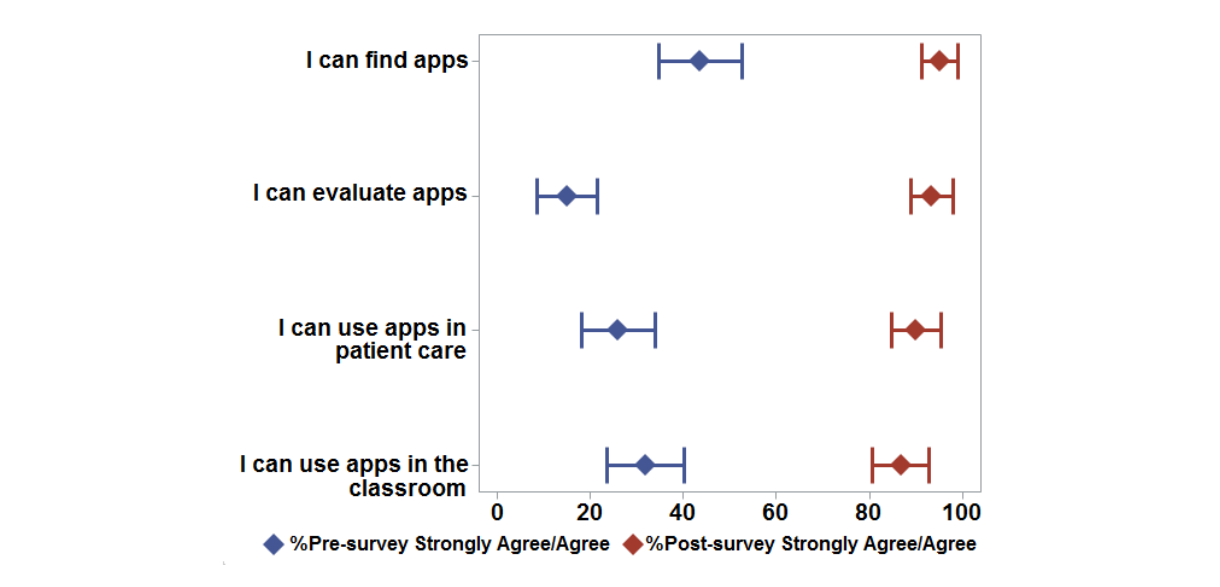
Figure 2. Student assessment of evaluation technique. Proportions (diamonds) and 95% confidence intervals (horizontal lines) for the surveys conducted before (pre-survey) and after (post-survey) the learning